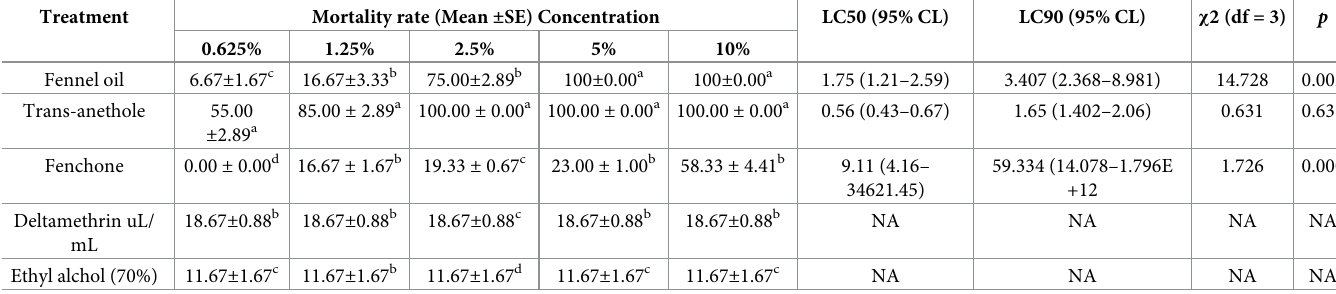
Means within the same column followed by different superscripts are significantly different (Duncan’s multiple range test: P � 0.05). NA = not